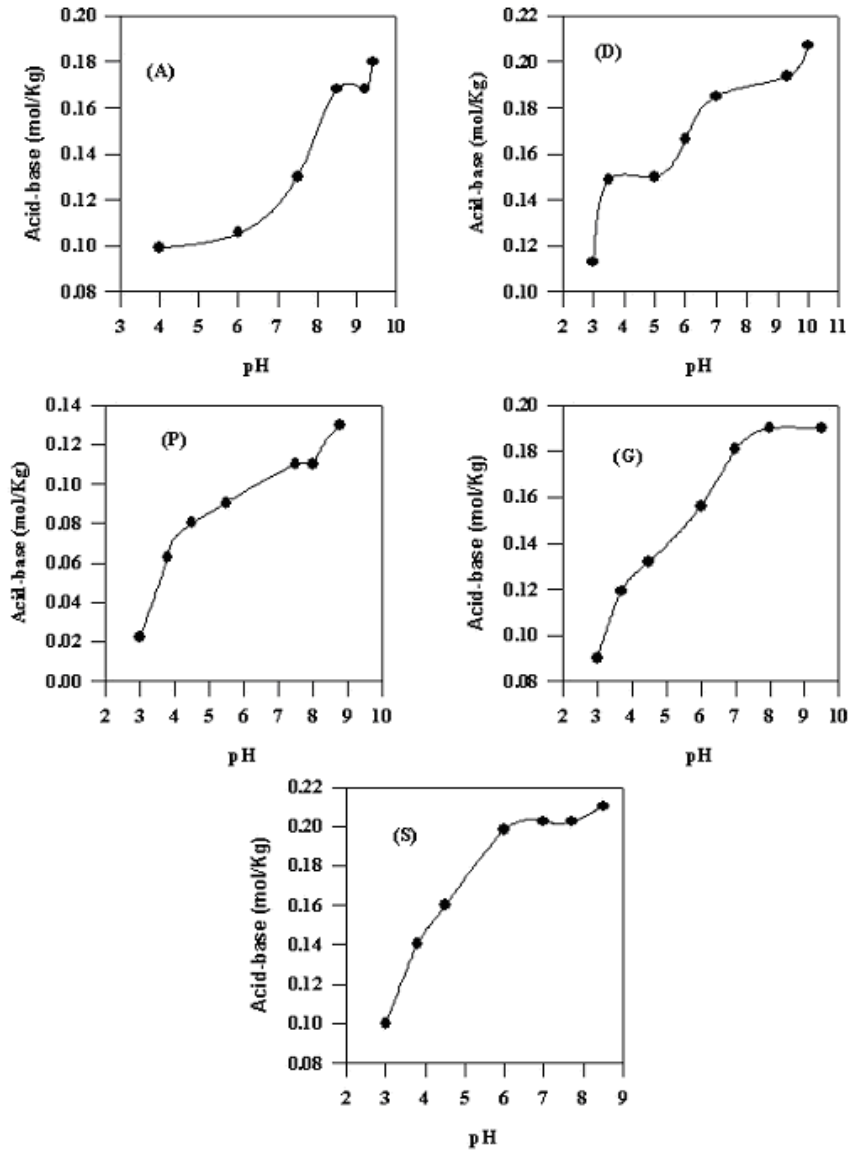
FIGURE 3 . Acid-base titration of the sediment samples A-S at 0.1 mol/l HClO 4 aqueous solution. electric surface potential ( ψ ) for the marine samples were calculated using Eq. 7 and 8. The obtained results were found to be more or less similar to that previously reported[15,16]. The concentrations of Fe, Al, and Si that dissolved in the aqueous phases at different pH are given in Table 6. Concentrations of Fe and Si were found to increase and decrease by increasing of the pH respectively. The release of Fe and Si were found to be dependent on the mineralogical composition of the sediment sample. No Al was released at the different pH for the sediment samples A and D. For the other samples, the concentrations of Al released were found to increase from 11 to 40 mol/l by the increasing of the pH from 3 to